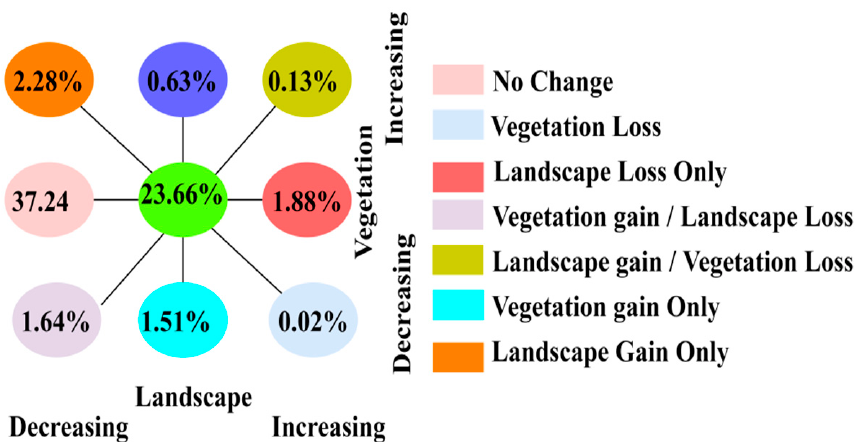
Figure 7. Vegetation and landscape changes.